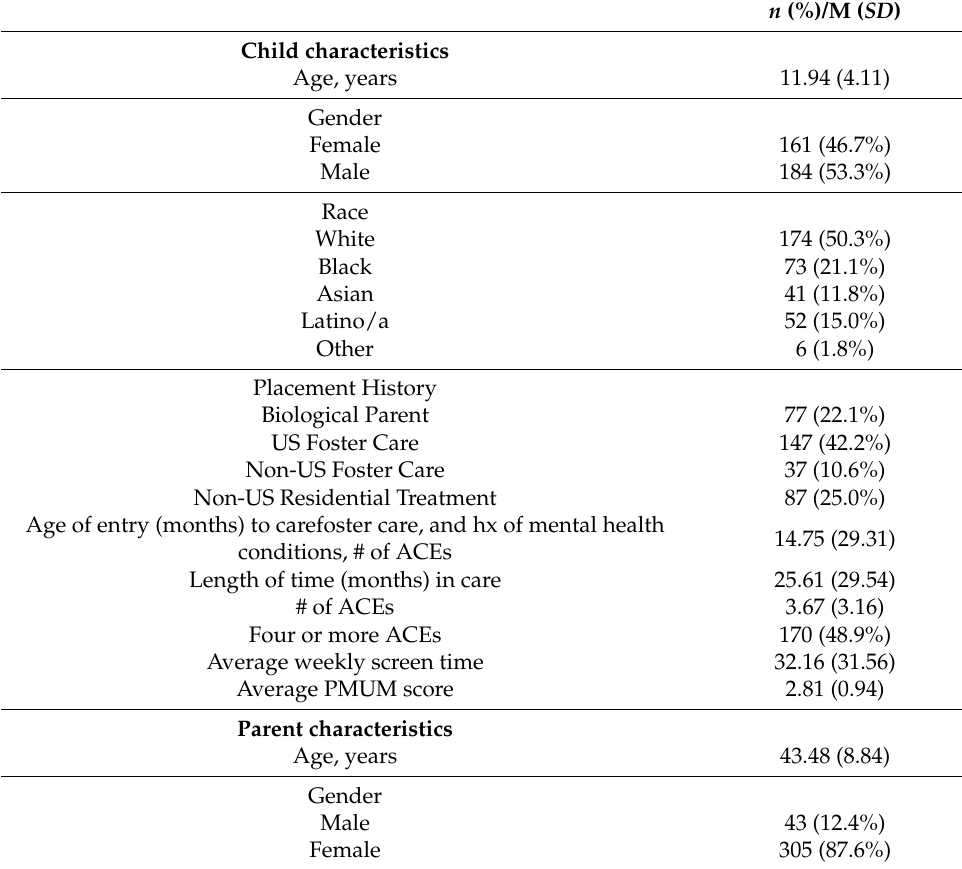
Table 1. Participant